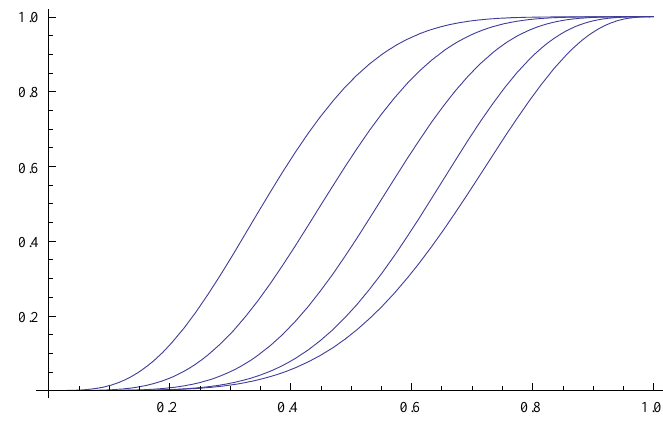
Figure 6. The reliability polynomial of the linear <10, f ,2> for f = 3,4,5,6,7.